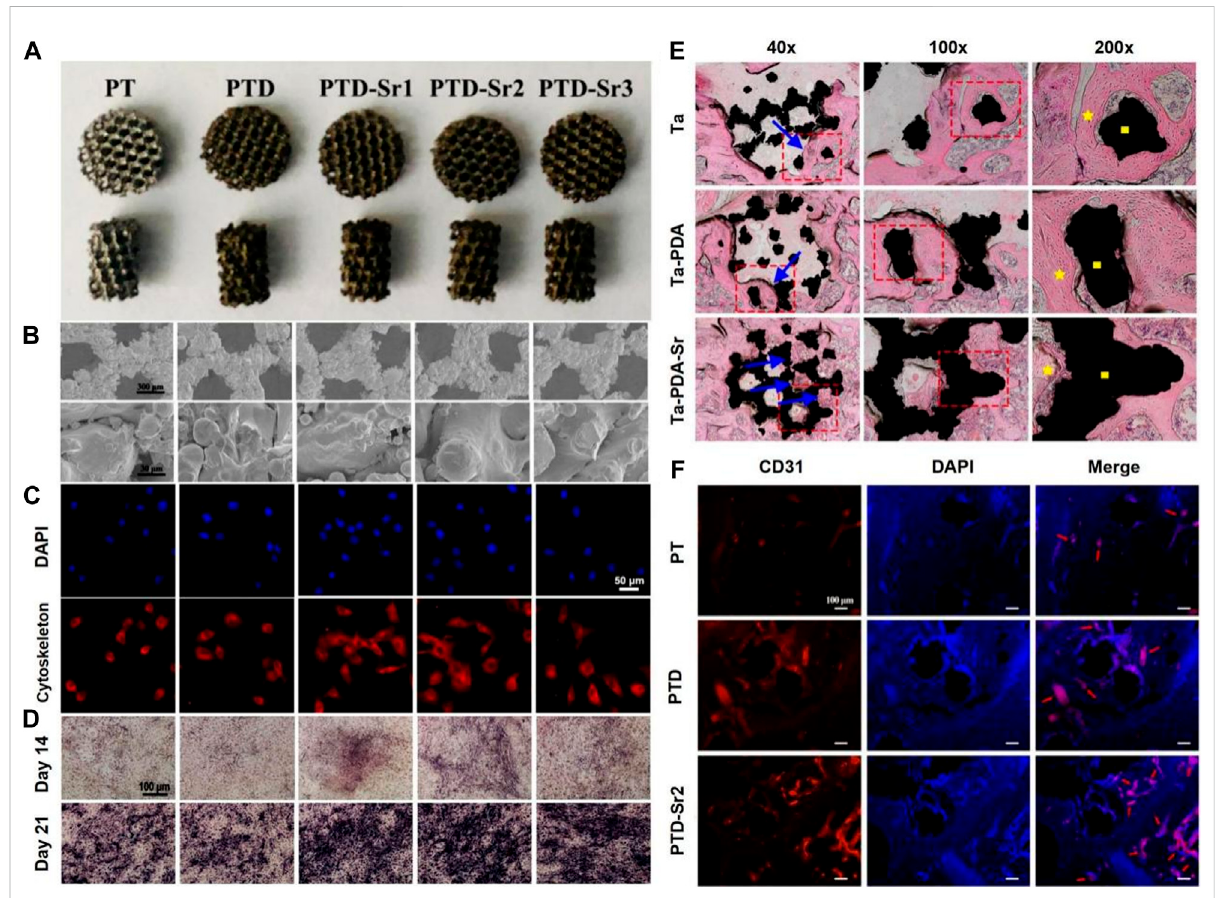
3D-printed tantalum scaffold coatedwith polydopamine improve osteointegration and angiogenesis (Cheng et al., 2021). (A) Optical images of PT,PTD,PTD-Sr1,PTD-Sr2,andPTD-Sr3. (B) SEMimagesofPT,PTD,PTD-Sr1, PTD-Sr2,andPTD-Sr3. (C) AdhesionofrBMSCsonPT,PTD,PTD-Sr1, PTD-Sr2, and PTD-Sr3. (D) ALP staining images of rBMSCs after stimulation with various extracts from PT, PTD, PTD-Sr1, PTD-Sr2, and PTD-Sr3. (E) HE stains of PT, PTD, and PTD-Sr2 after implantation for 8 weeks (F) CD31 and DAPI immuno fl uorescent staining images of PT, PTD and PTD- Sr2 after implantation in rat femur condyles. (Reproduced from the references with